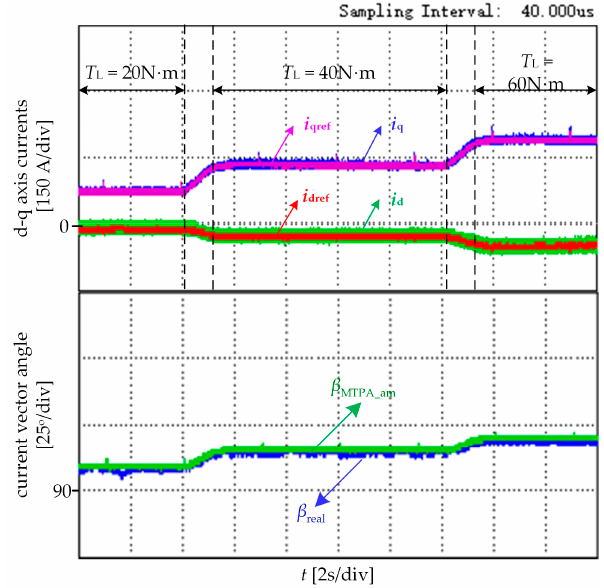
Figure 10. The dynamic experimental waveforms of MTPA control.